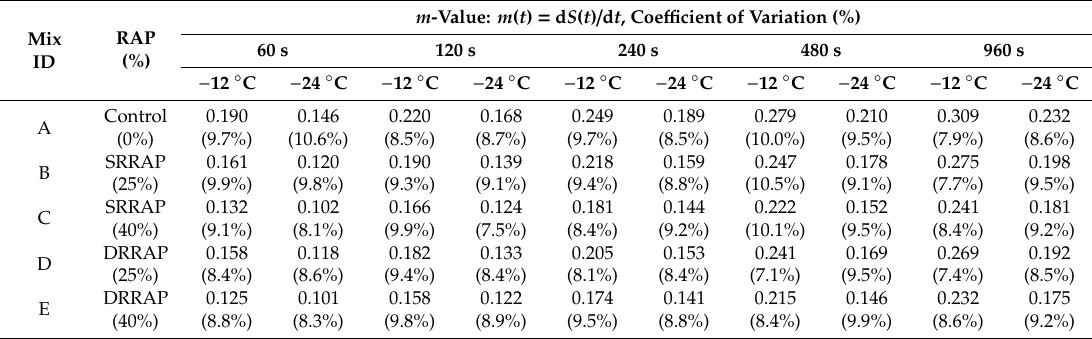
Table 4. Results of m (t) at t = 60, 120, 240, 480, 960